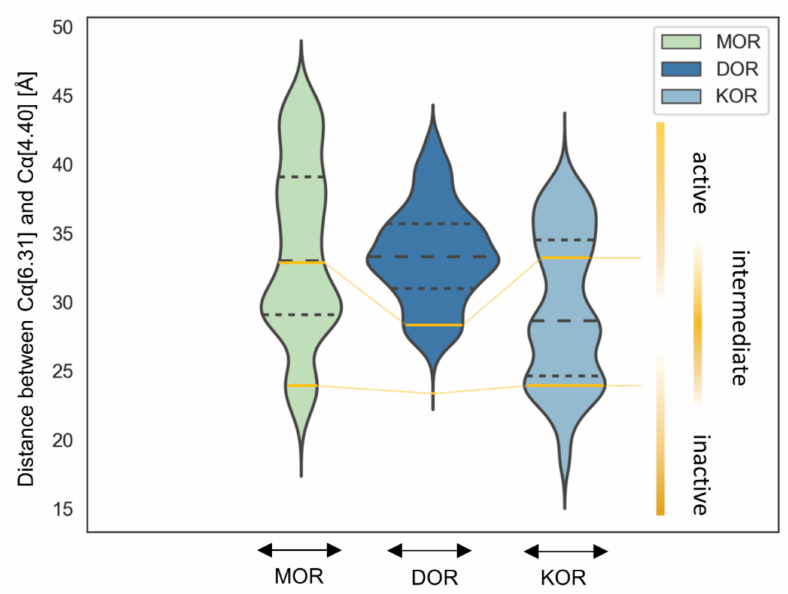
Figure 8. TM6 translocation. Measurement between the alpha carbon atoms of 6.31 at the bottom of TM6 (MOR: R278 6.31 , DOR: R257 6.31 , KOR: R270 6.31 ) and 4.40 at the bottom of TM4 (MOR: R184 4.40 , DOR: A163 4.40 , KOR: L173 4.40 ) over the simulation time. The width of the plot corresponds to the frequency of the measured distance. Dashed black lines represent quantile. Yellow solid lines indicate the analog measured distances at the active state crystal structures (PDB-ID: 5C1M for MOR, 6PT2 for DOR and 6B73 for KOR) and inactive state crystal structures (PDB-ID: 4DKL for MOR, 4N6H for DOR and 4DJH for